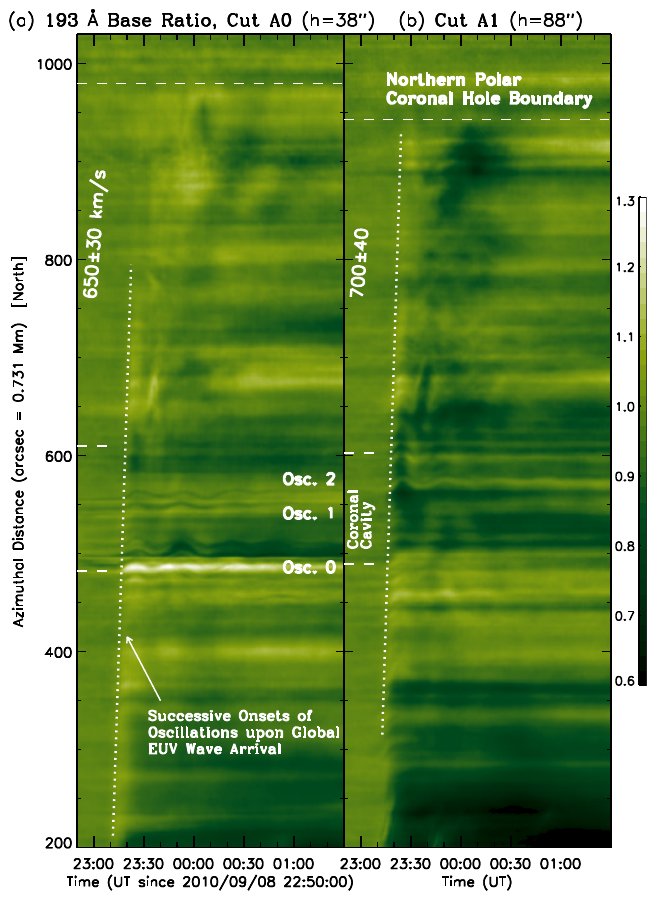
Figure 33: Distance-time intensity stack plots along two azimuthal cuts in the coronal wave event of 2010 Sep 8, imaged at 193 ˚A with SDO/AIA. The plots show a sequence of transverse oscillations that are excited by the arrival of the coronal wave at increasing distances. Image reproduced with permission from Liu et al. (2012), copyright by